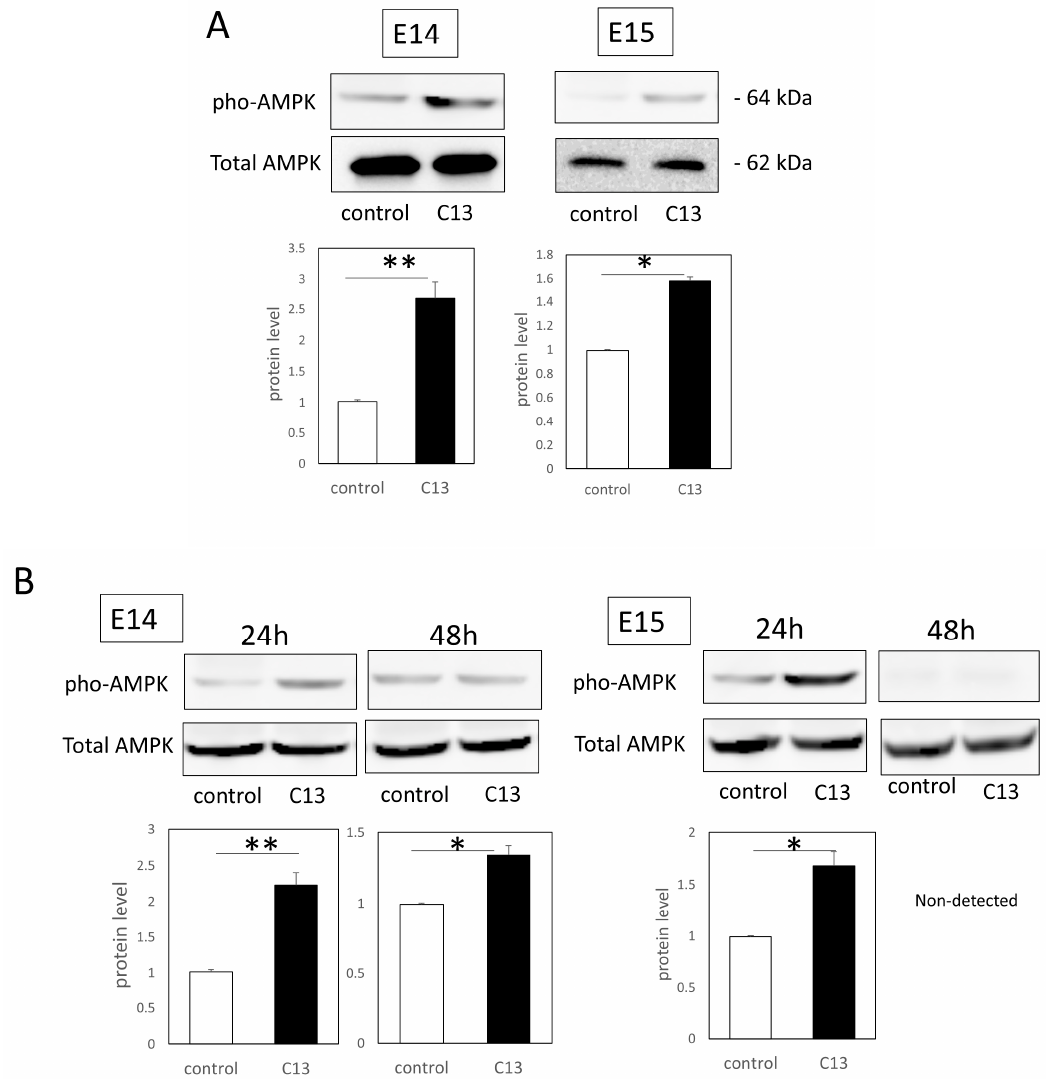
Figure 2. Alteration of AMPK activity with C13 in fetal mouse epidermis. ( A )The effect of C13 on mouse embryonic epidermal keratinocytes at E14 and E15, and ( B ) the effect of C13 on the wound healing process of mouse fetuses at E14 and E15. The total AMPK expression level was used to determine the AMPK expression level of the phosphorylated form of AMPK. * p < 0.05, and ** p < 0.01.